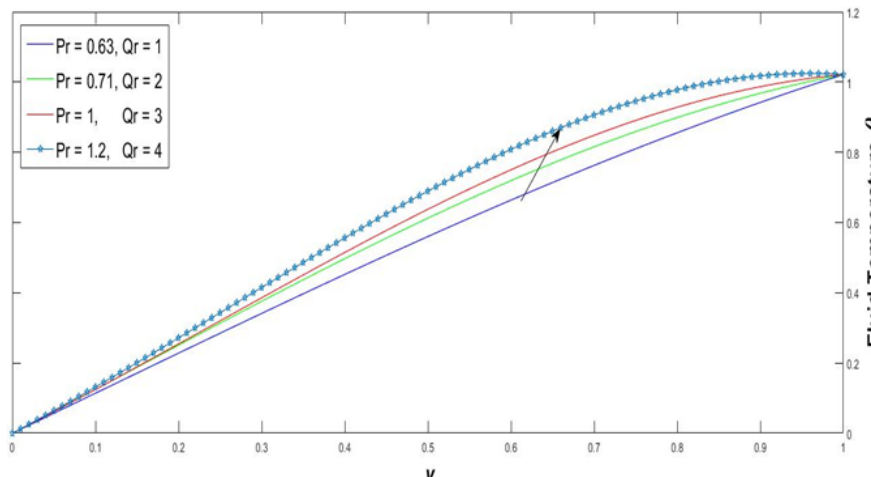
Figure 19. Temperature field for various Prandtl